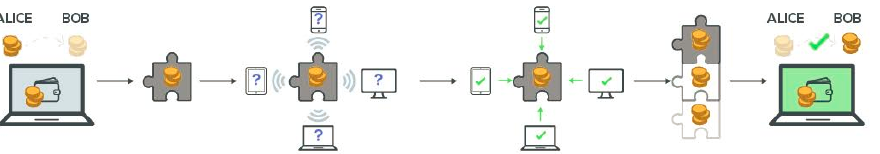
Figure 2. A brief Bitcoin overview: when Alice sends Bitcoin to Bob, her transaction is represented by a block, which is broadcasted to the network. When it is validated, the block is attached to the Blockchain, the transaction is performed, and Bob gets the